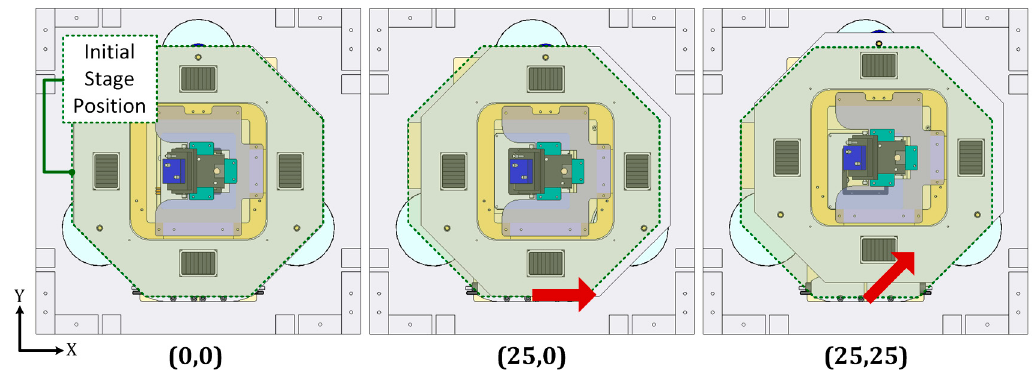
Figure 3. Considered NanoPla representative 2D-motions along the long travel range. ( Left ) Initial stage position; ( Middle ) X-displacement of 25 mm; ( Right ) XY-displacement of (25, 25) mm.